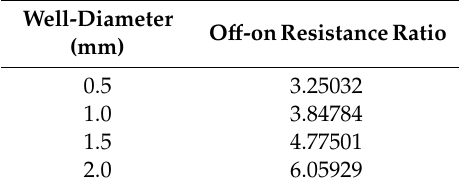
Table 1. O ff -On resistance ratio for di ff erent well diameter size.